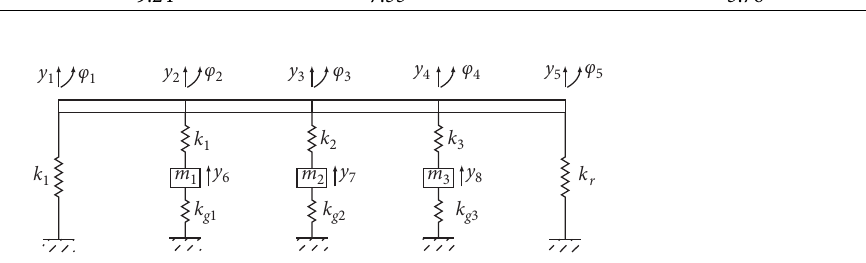
Figure 7: Test-case 3: sketch of the system. Table 10: Test-case 3: original and modified system design variables and constraints.